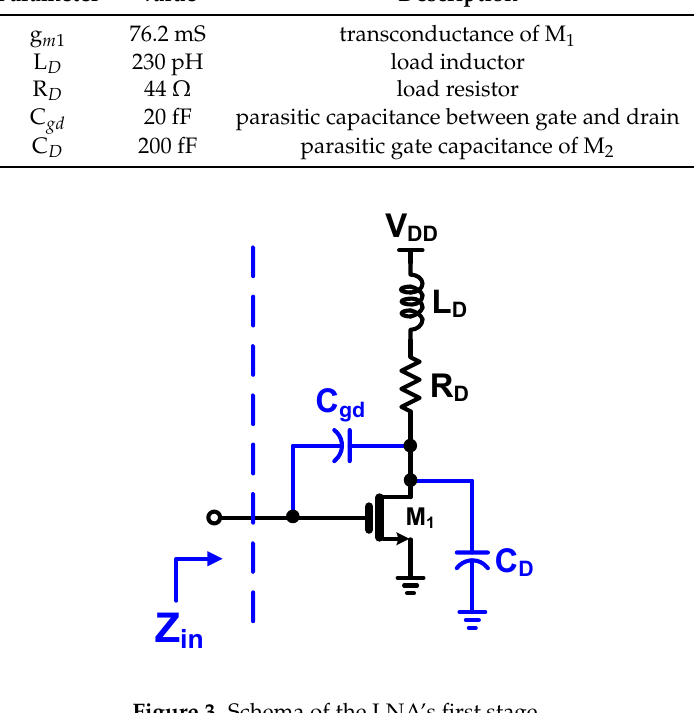
Figure 3. Schema of the LNA’s first stage.